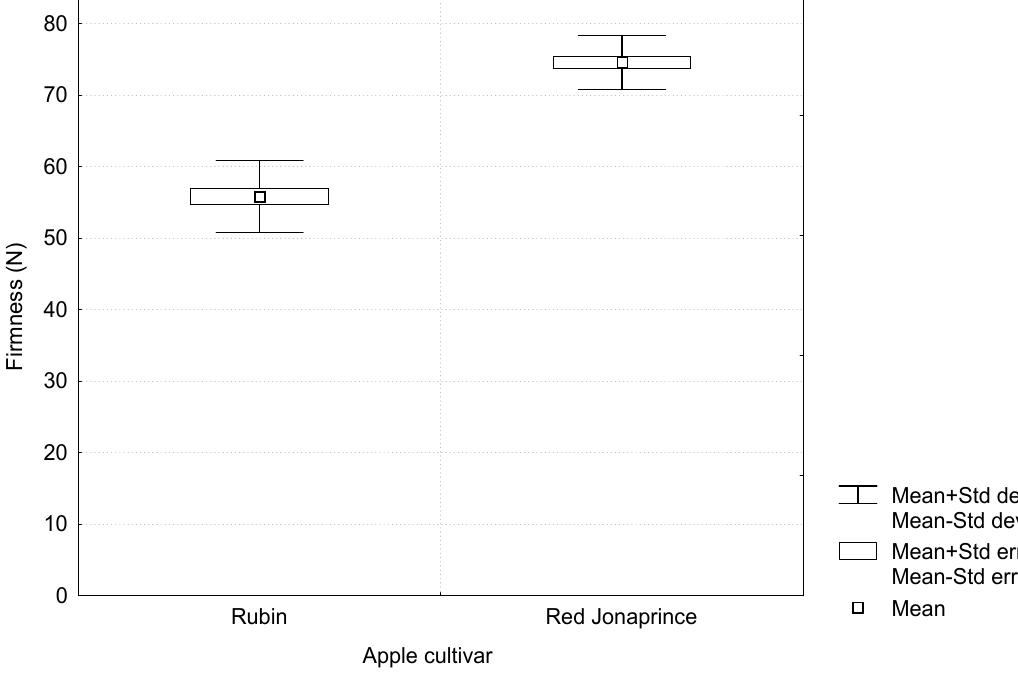
Figure 3. Firmness of the tested apple cultivars.